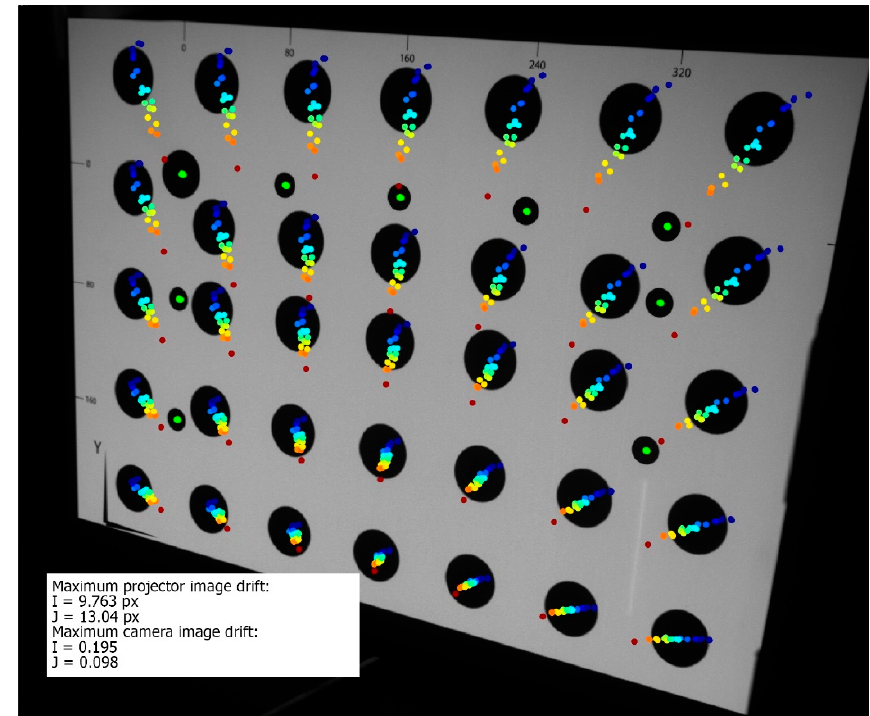
Figure 11. Thermal image drift registered during tests performed in the thermal chamber. The marker trajectories are multiplied 20 times. The marker colors show the temperature of the projector, corresponding to the colors in Figure 10.